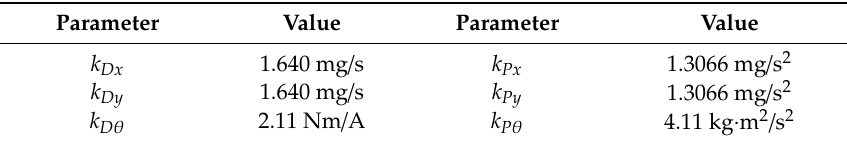
Table 4. Parameters of the feedback